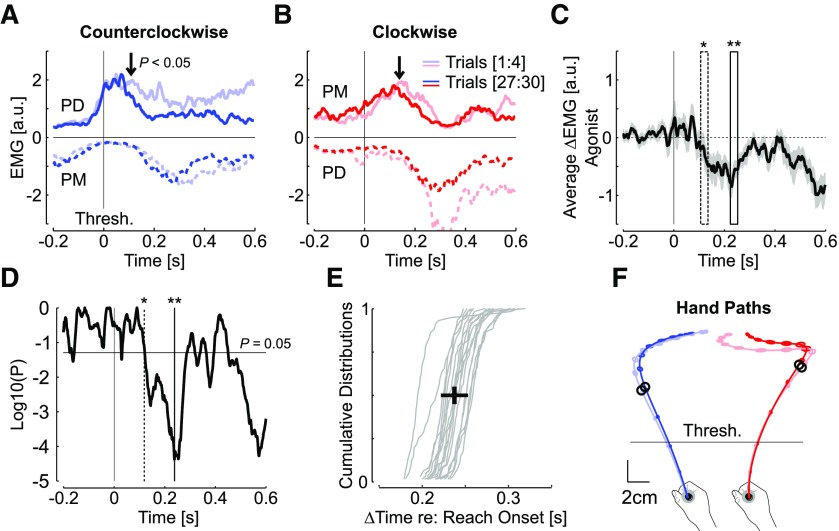

A, Activity of posterior deltoid (PD; agonist, solid), and pectoralis major (PM; antagonist, dashed) averaged across the first four (light blue) and last four counterclockwise (dark blue) perturbation trials. The vertical arrows illustrate the moment when a sliding paired comparison of the agonist activity averaged in a 30-m window dropped below p < 0.05. Traces were aligned to the position threshold corresponding to one-third of the reach path to reduce variability. B, Same as panel a for clockwise perturbation trials. The position threshold is also represented. C, Grand average of the difference between the agonist activities of the first four and last four force field trials, aligned to the position threshold and averaged across muscles and participants (n = 18). The gray area corresponds to the standard error of the mean. The dashed window is the first window that displays a significant difference from sliding paired comparison (*p < 0.05, width = 30 ms). The solid window is the window associated with the minimum p value (**p < 10−4). D, p value of the sliding paired comparison performed on the data from C. All EMG traces were smoothed with a 5-ms sliding window for illustration purposes. E, Cumulative individual distributions of the delay between movement onset, and the moment when the p value of panel d dropped below 0.05. This moment corresponds to the time of threshold crossing plus 122 ms. The median delay between movement onset, and this time was 237 ± 15 ms (mean ± SD across participants, n = 18). F, Average hand paths and standard dispersion ellipses for the first four and last four trials in each direction, Dispersion ellipses are displayed 50 ms (see Materials and Methods). The black dots represent the moment corresponding to the vertical arrows of A, B.